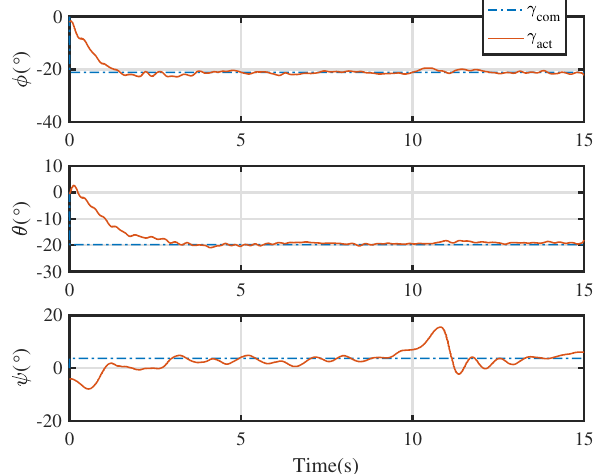
Figure 11. Attitude profiles tracked during real-world flight